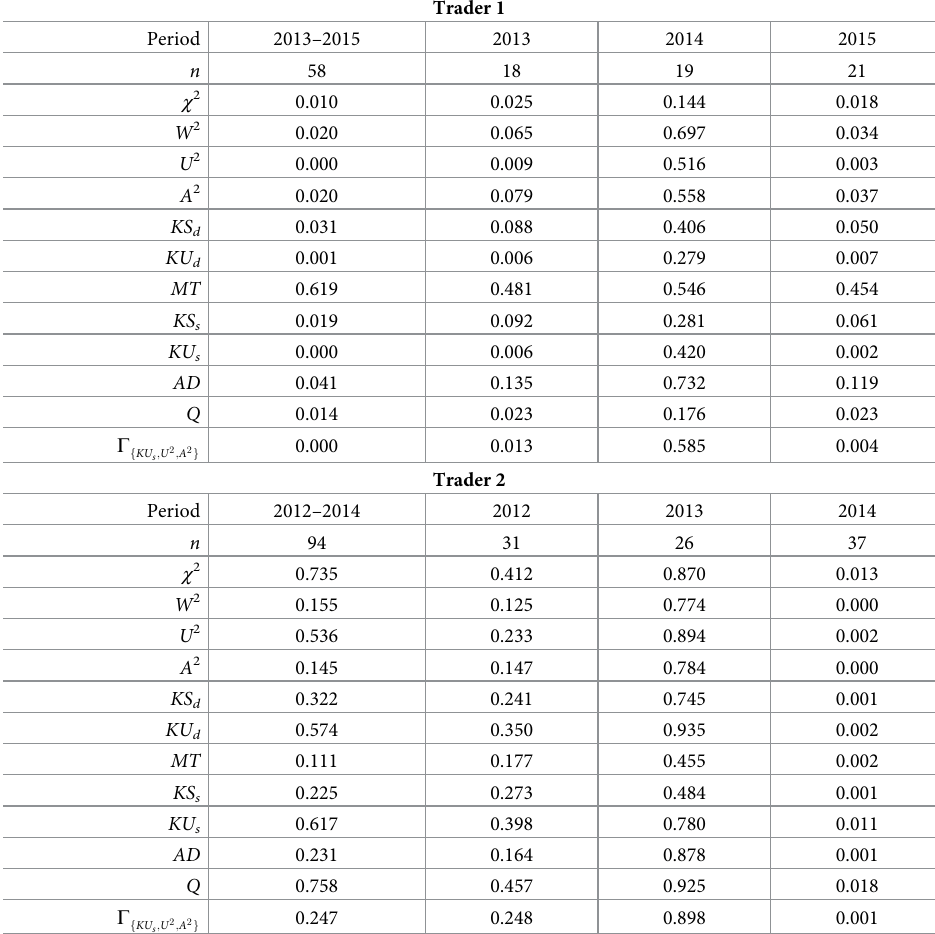
Table 7. P-values of Benford tests applied on the import values declared by two